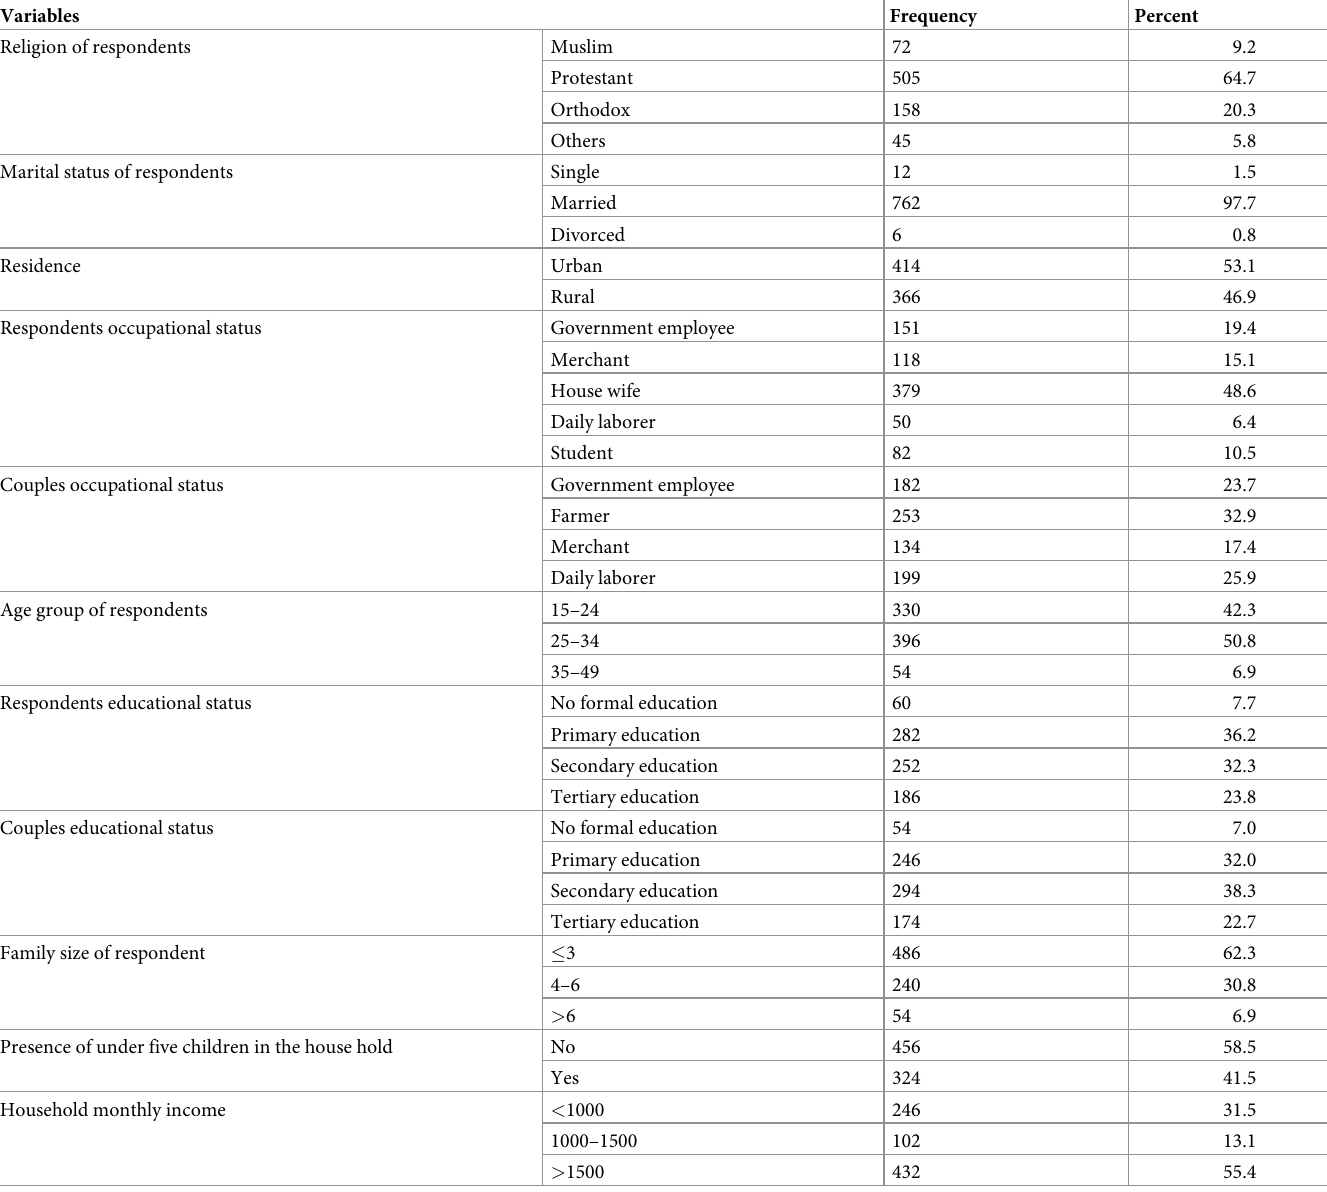
Table 1. Socio-demographic characteristics of participants attending antenatal care services at public hospitals of West Wollega Zone,